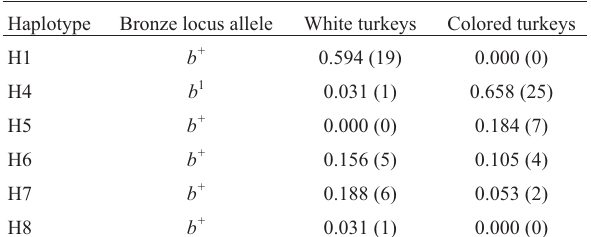
Table 2 - MC1R haplotype frequencies in sampled individuals. Absolute numbers are given in